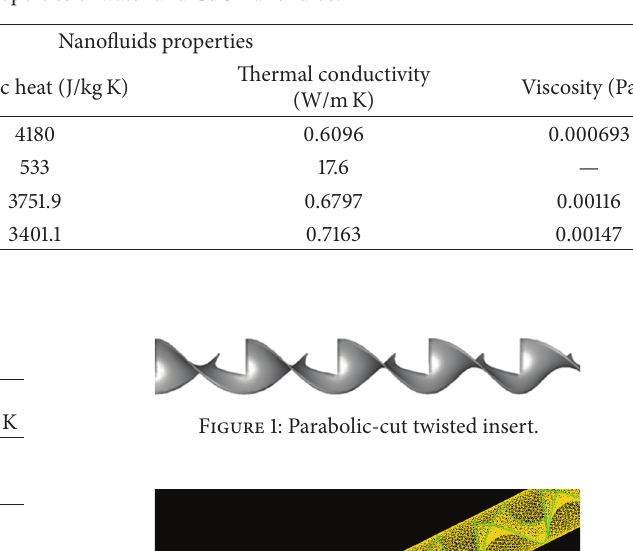
Table 1: Thermophysical properties of water and CuO nanofluids.